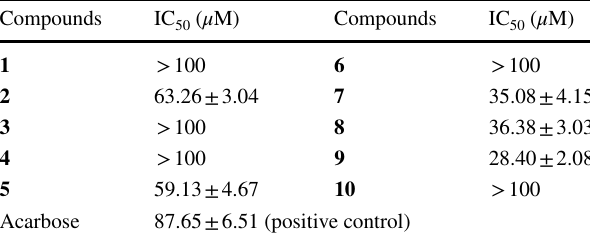
Table 3 α-Glucosidase inhibitory activities of compounds 1 – 10